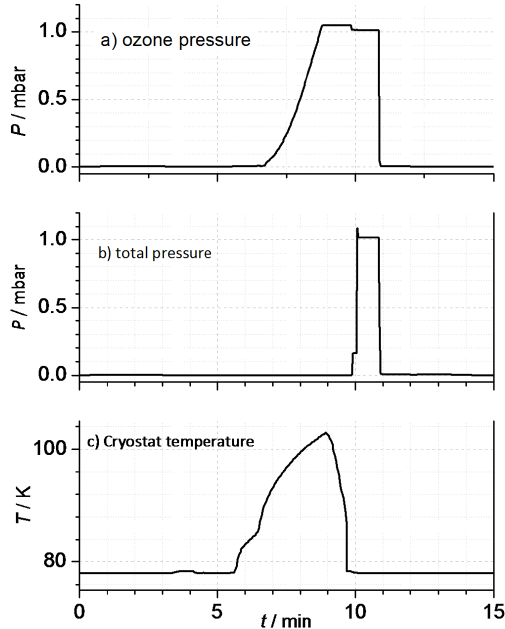
Figure 2. The measured values of key parameters during a typi- cal evaporation–condensation cycle: (a) ozone partial pressure de- duced from the absorption measurement P (O 3 ) , (b) total pressure P T measured with the Baratron gauge and (c) temperature T cryo in- side the